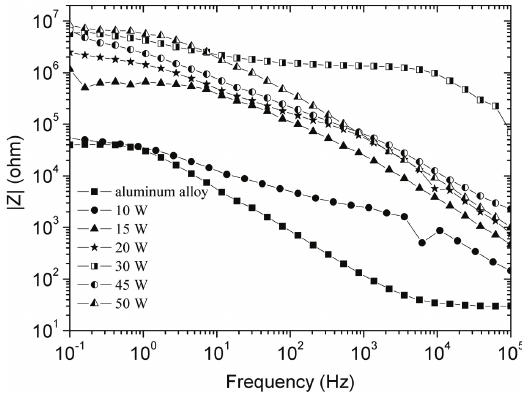
Figure 15. Impedance modulus versus frequency for the films deposited from HMDSO/O on the 2024 Al alloy using discharge 2 powers ranging from 10 to 50 W.